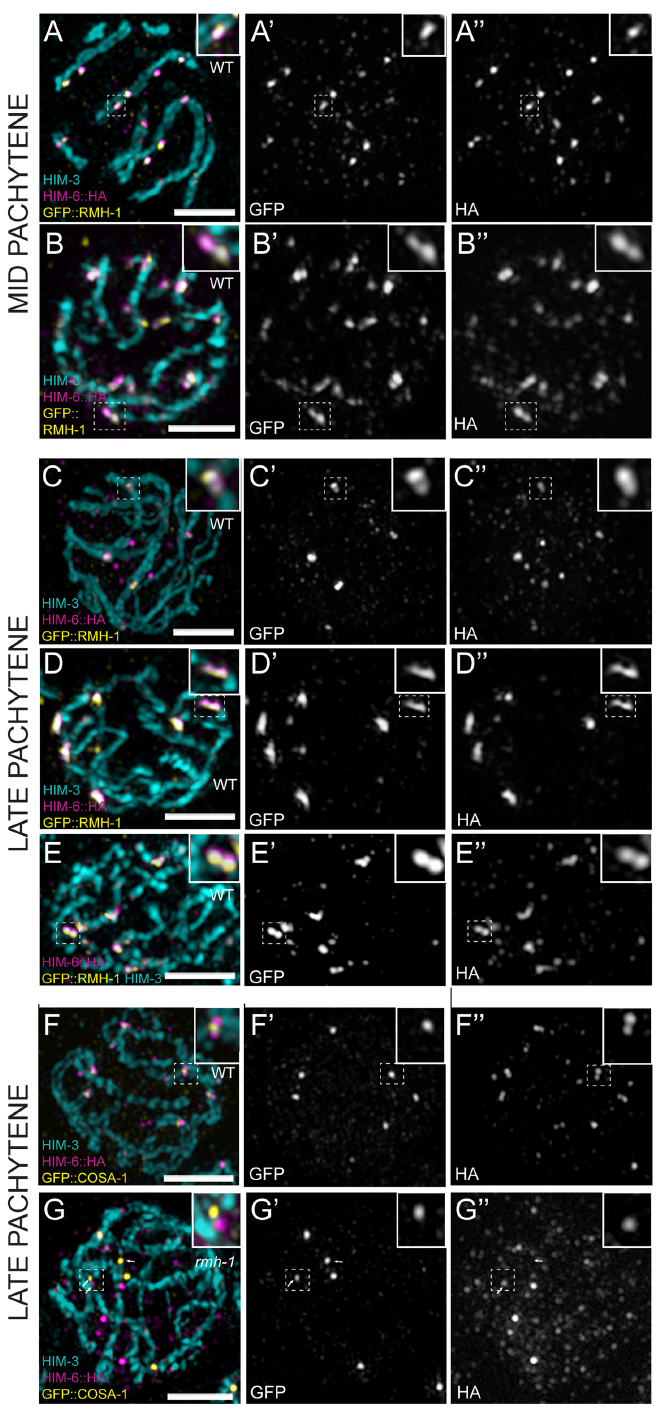
Fig 6. Foci of RMH-1 and BLM are resolved as doublets or elongated structures during the pachytene stage. (A – G) Single pachytene nuclei imaged by SIM. (A – B) In the WT, HIM-6 and RMH-1 colocalize in MP. Foci appear elongated or as a doublet (see insets). (C – E) In LP, RMH-1 and HIM-6 are concentrated at CO sites contained in a structure resolvable into a doublet (see insets). (F) Colocalization of HIM-6 and COSA-1 at CO sites in WT. (G) In rmh-1(jf54) , HIM-6 does not colocalize with COSA-1 at CO sites (white arrow) but can be found in close proximity (white arrows). Scale bar 2 μ